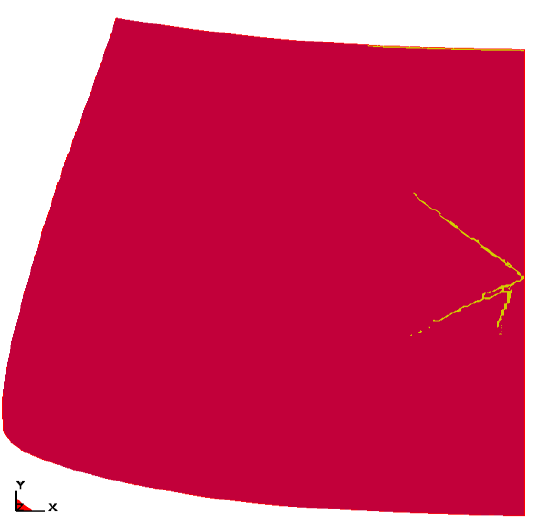
Figure 6. Results of simulation of head impactor impact on the windscreen of an Opel Astra — temp. = − 30 °C ( t = 21 ms).